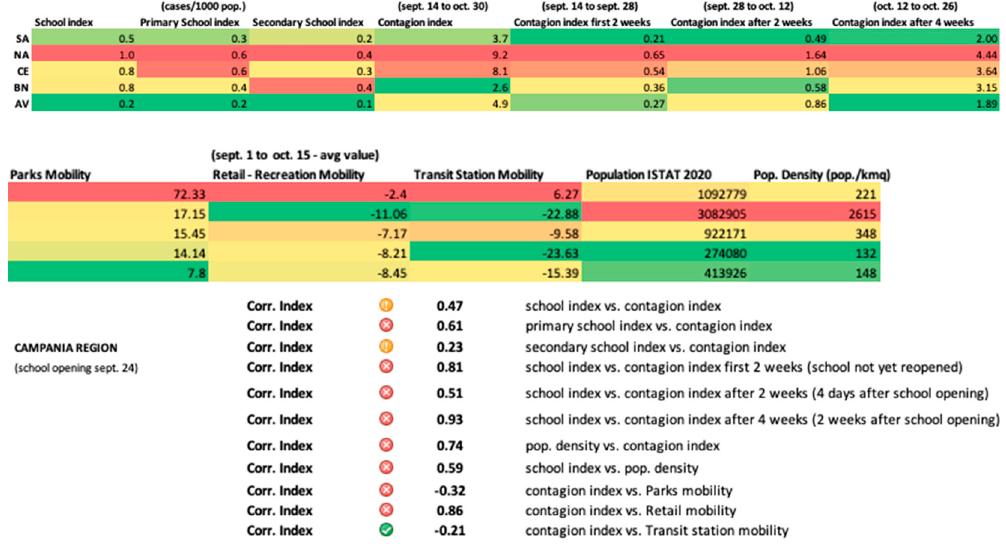
Figure 4. Campania Region data set for school contagion index and overall contagion. Correlation study.